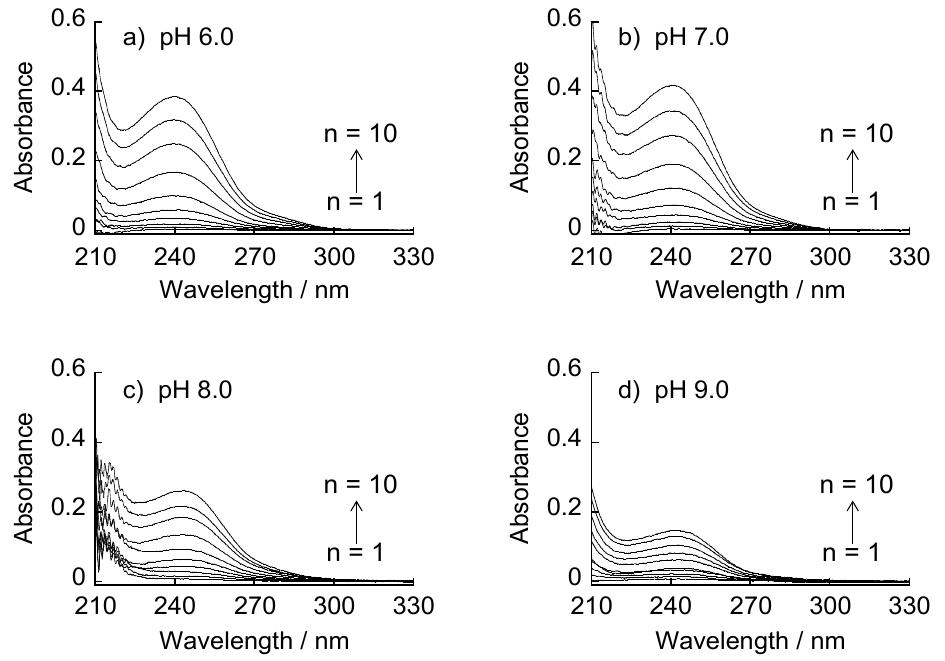
Figure 3. UV absorption spectra of (AGA/39%PBA-PAMAM) n LbL films ( n = 1–10) prepared at pH 6.0–9.0. ( a ) UV absorption spectra recorded at pH 6.0; ( b ) UV absorption spectra recorded at pH 7.0; ( c ) UV absorption spectra recorded at pH 8.0; ( d ) UV absorption spectra recorded at pH 9.0.